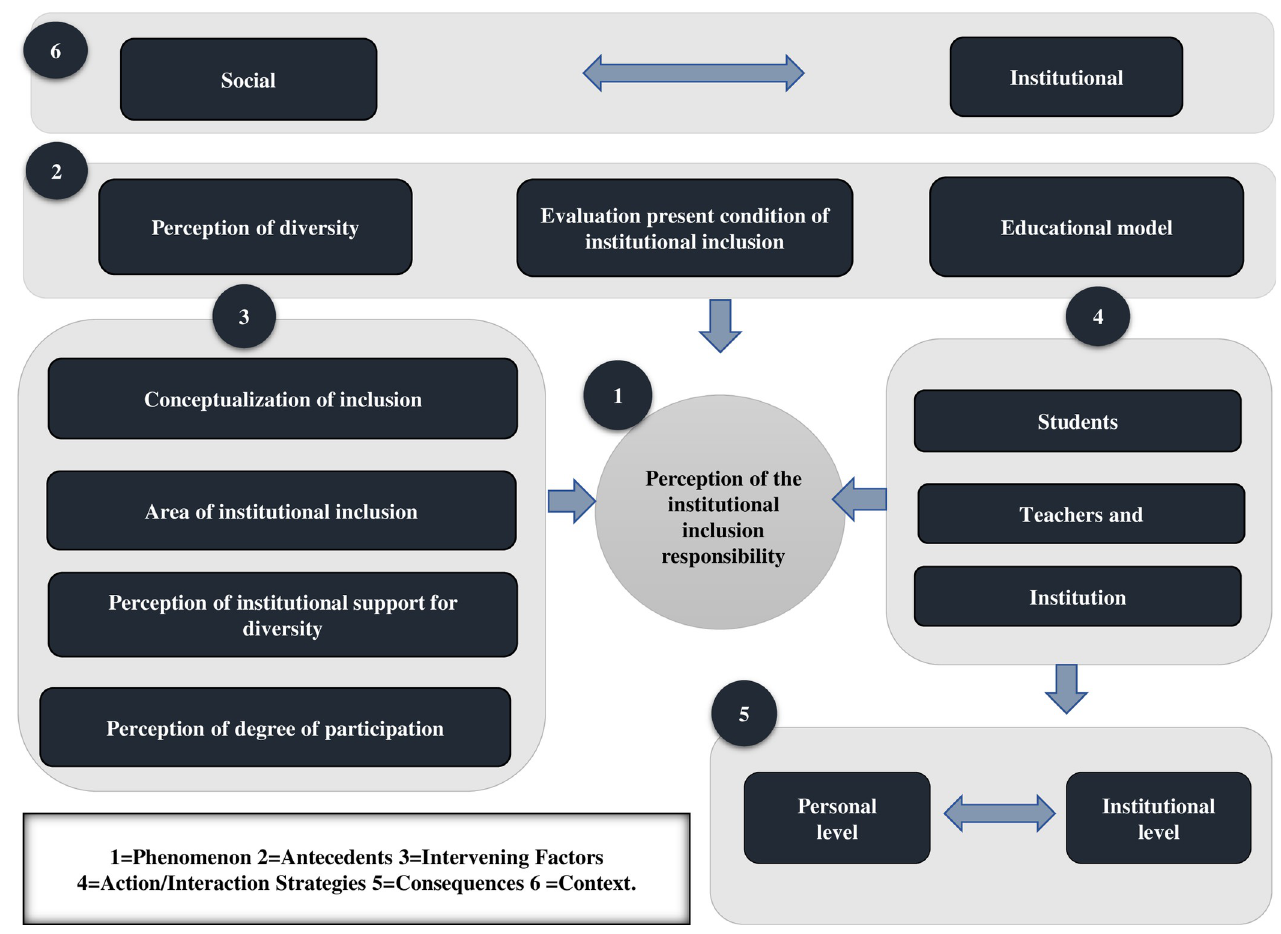
Fig 1. Axial model for perception of the institutional inclusion